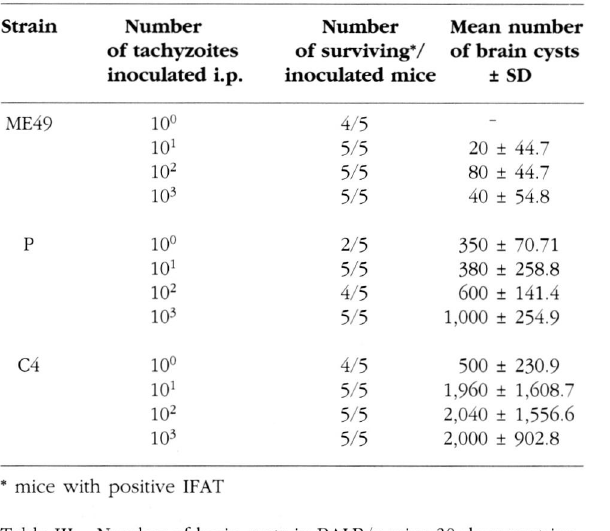
Table III - Number of brain cysts in BALB/c mice 30 days post ino­ culation with tachyzoites of ME49, P and C4 strains of Toxoplasma gondii.